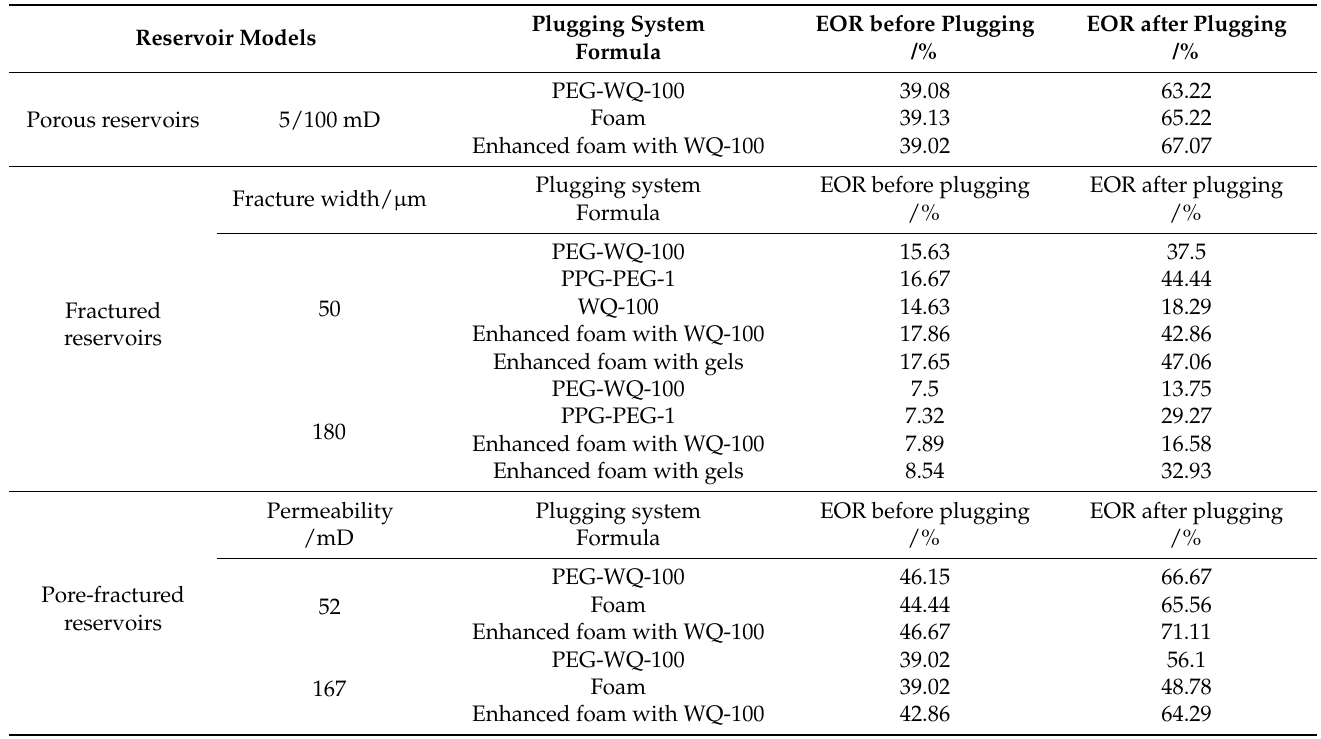
Table 10. EOR efficiency of enhanced foam at varying reservoirs